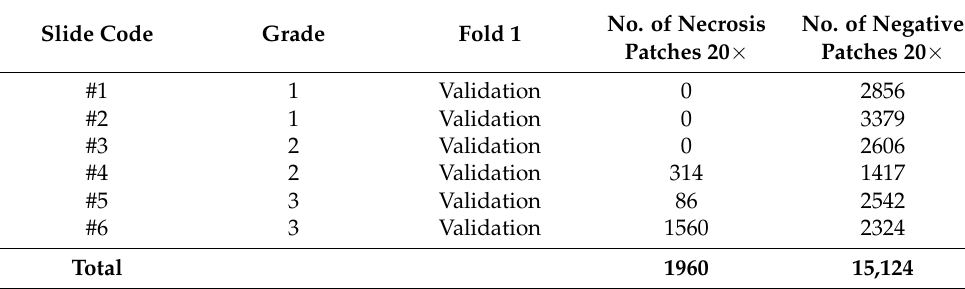
Table 1. The data in the table relate to information for the training and validation datasets for each experiment (folds 1, 2 and 3). Each table (folds 1, 2 and 3) contains information about WSI number, tumour grade, number of patches extracted from necrosis areas (positive patches) and normal tissue (negative patches) for each WSI. Each table also indicates the total number of positive and negative patches used for training and